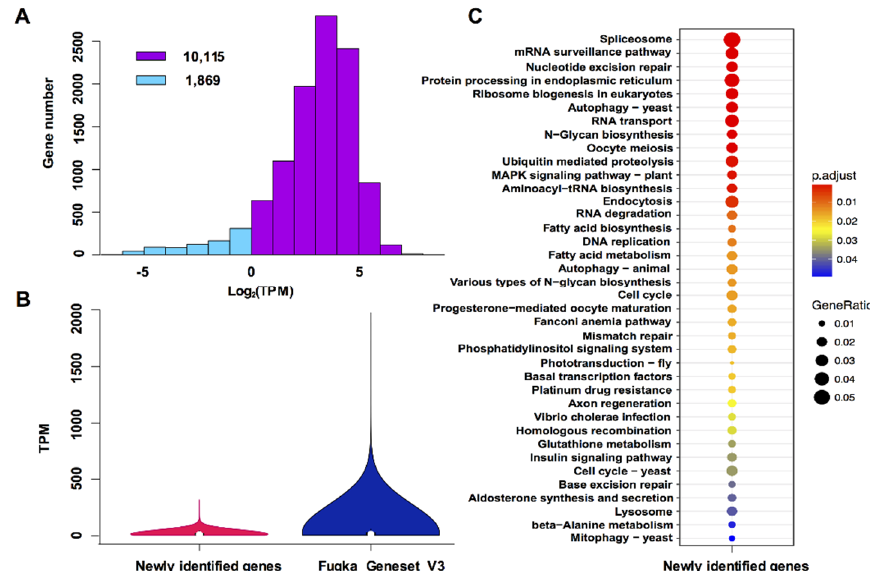
Figure 2. Expression of newly identified genes and significantly enriched pathways: ( A ) Bar chart of gene expression. Blue, transcripts per million (TPM) < 1; pink, TPM > 1. ( B ) Comparison of expression profiles between newly identified genes and all genes in Fugka_Geneset_V3. ( C ) Significantly enriched KEGG pathways of newly identified genes (adjust p -value < 0.05).